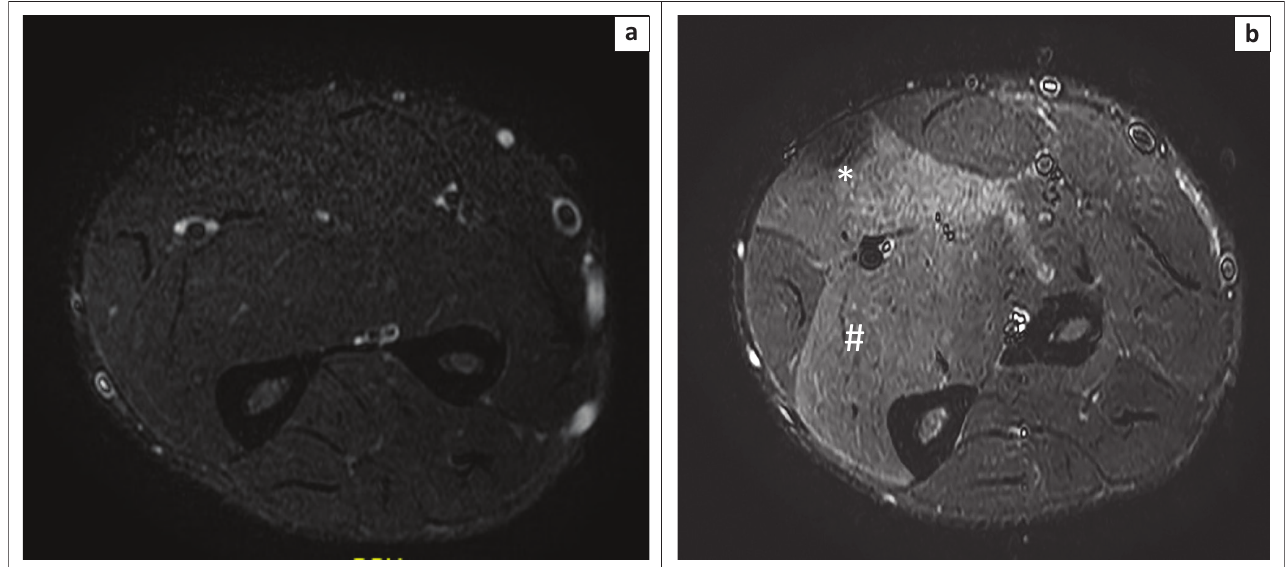
FIGURE 4: Pre-exercise (a) and post-exercise (b) sequences in a CECS patient demonstrating clear signal increase in the flexor digitorum superficialis ( * ) and flexor digitorum profundus (#) muscles after